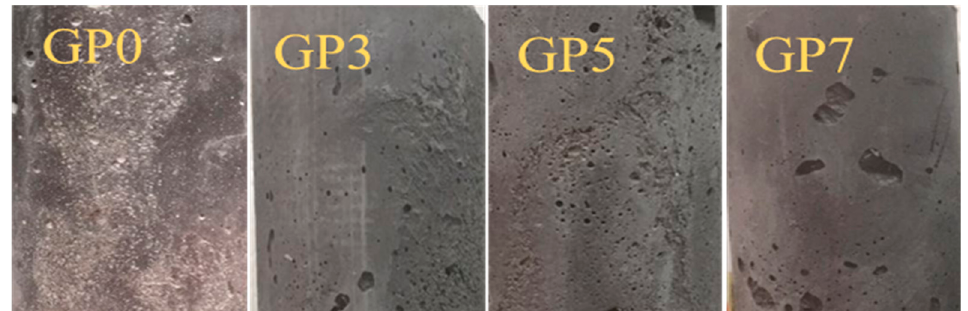
Figure 10. Physical appearance of all the geopolymer specimens.